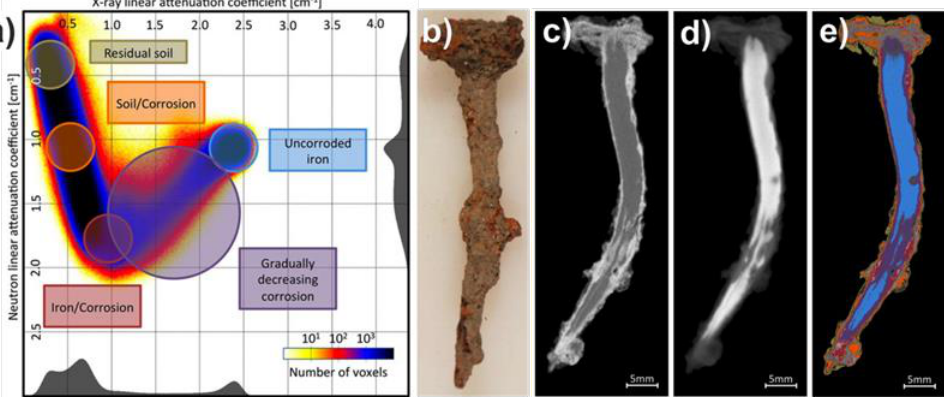
Figure 4. Bivariate histogram of corroded nails identifying different phases present ( a ); photograph ( b ); neutron ( c ), X-ray ( d ), and bivariate image ( e ); (image reprinted from ref. [12]).